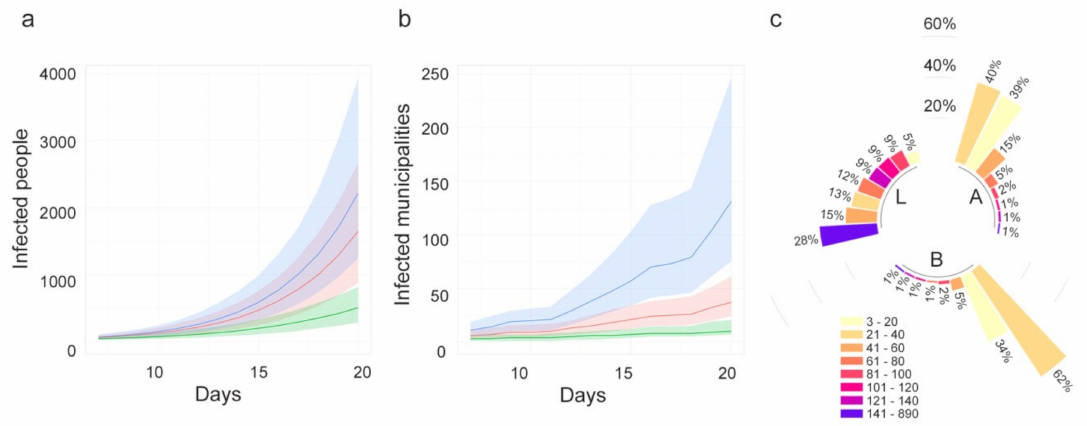
Figure 14. ( a ) Number of estimated infected people (median values and 95%CI) and ( b ) estimated infected municipalities (median values and 95% confidence interval, CI) when the epidemic starts in one seed and lasts 21 days. ( c ). The blue line represents Lombardy, red line is Abruzzi region and green line, Basilicata region. Degree distribution in the three regions: L = Lombardy, A = Abruzzi, B = Basilicata. Bars are in class percentage descending